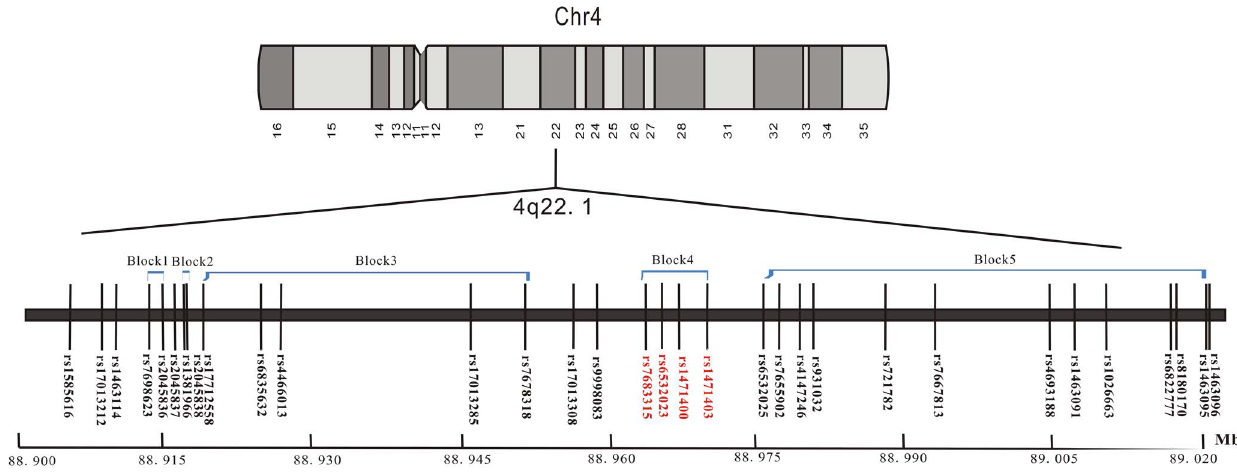
Figure 1. Distribution of 32 SNPs across the 4q22.1 region and their relationship with linkage disequilibrium blocks.